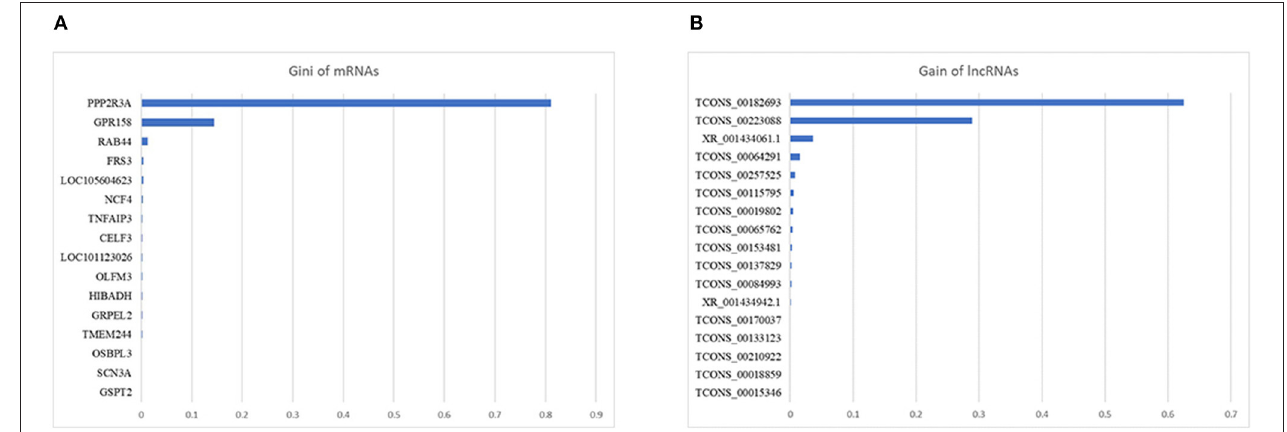
FIGURE 4 | Gain value of the mRNAs (A) and lncRNAs (B) selected by the two-step machine learning approach (RX).